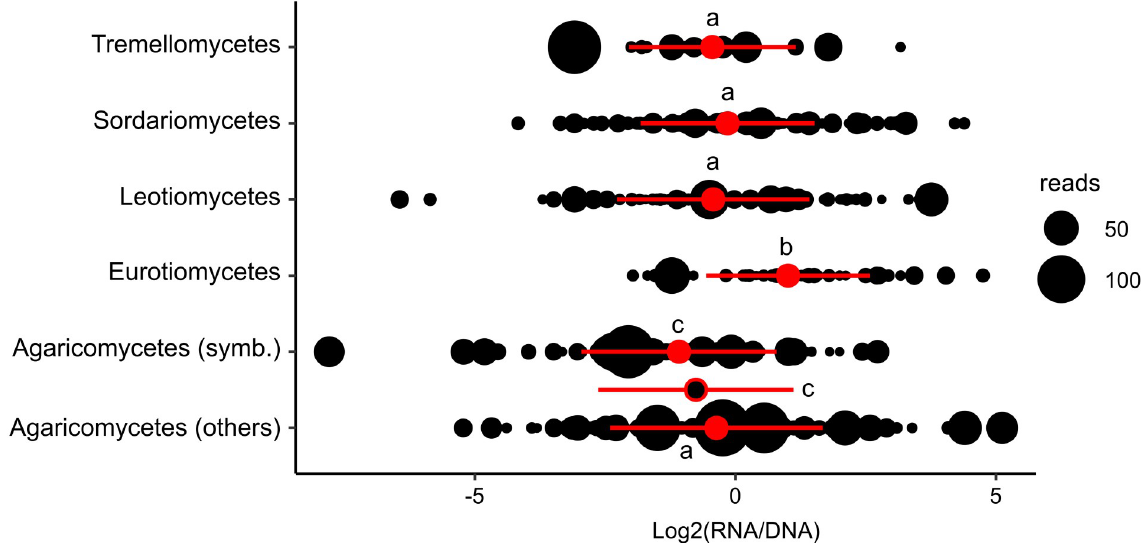
Fig 2. Fungal classes significantly differ from each other with respect to MOTU RNA:DNA read ratios. For each MOTU (black dots), its log 2 -transformed ratio ([No. of RNA reads]: [No. of DNA reads] +1) in the whole dataset was plotted on a horizontal axis. Symbol size is proportional to the relative abundance (average reads number among the 24 samples) of the taxa in the dataset. For Agaricomycetes we separately considered symbiotic (symb, mainly ectomycorrhizal), saprophytic and undefined (others) MOTUs. Red circles correspond to the mean values and red bars to standard deviations. In the case of Agaricomycetes, the global mean value for this class (symbiotic + non-symbiotic species together) is indicated by a black dot with red margin. Identical letters above the mean values (a, b or c) indicate which of the distributions are statistically similar (P > 0.05; Kruskall-Wallis test and Dunn’s post hoc test).